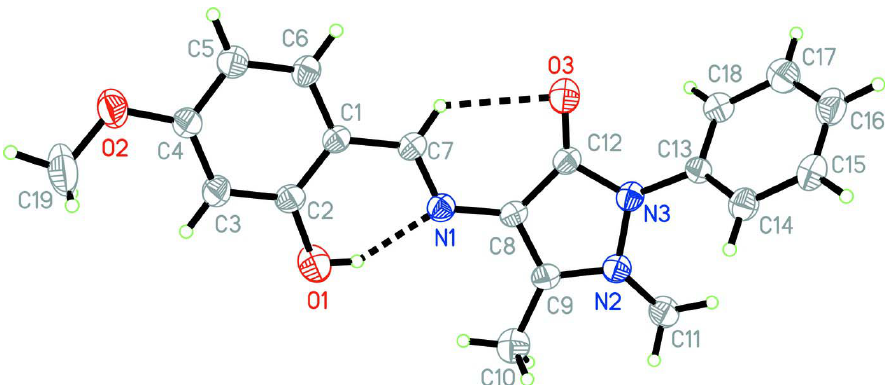
Figure 1 The molecular structure of the title compound, showing 30% probability displacement ellisoids. Only the major disorder component is shown. Intramolecular hydrogen bonds are shown as dashed